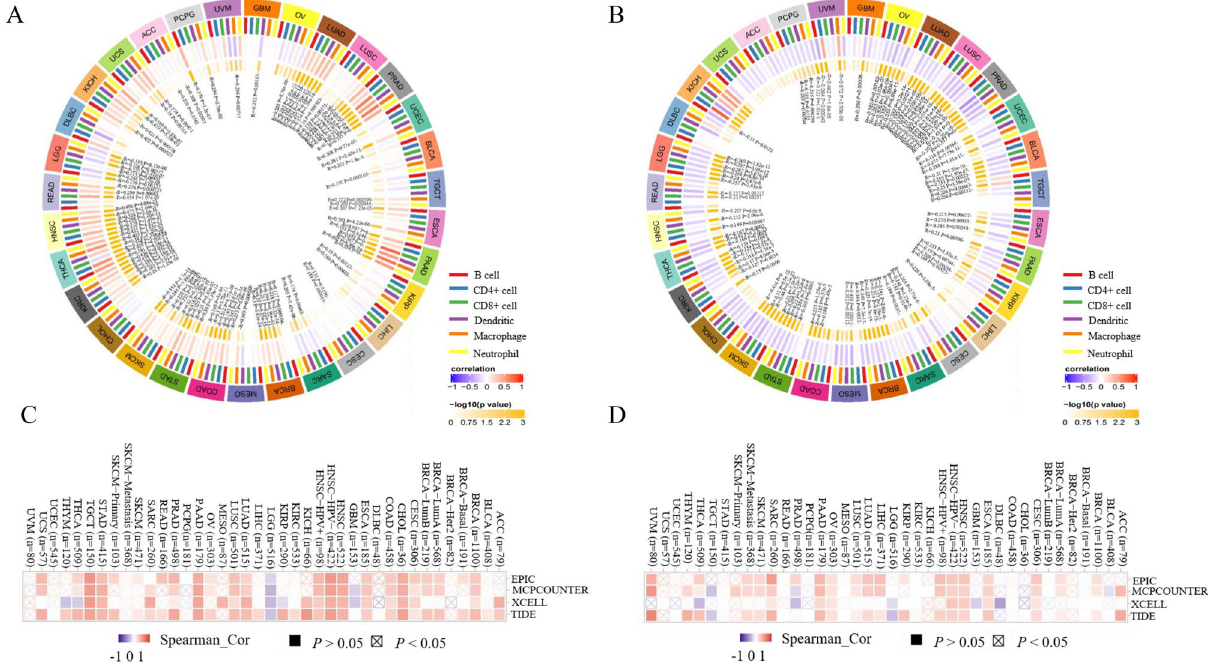
Figure 6. The correlation between genes expression and immune infiltration levels in pan-cancer. The correlation between immune cells including B cells, CD4 + T cells, CD8 + T cells, neutrophils, macrophages, dendritic cells and PIK3R1 expression ( A ), PIK3R2 expression ( B ). Analysis through the SangerBox 3.0 tools (http:// sange rbox. com/ Index). The correlation between the immune infiltration level of cancer-associated fibroblast and the expression level of PIK3R1 ( C ), PIK3R2 ( D ). Analysis through the TIMER 2.0 (http:// timer. cistr ome. org/ datab ase). EPIC, MCPCOUNTER, XCELL, TIDE algorithms were utilized to analyze the correlation between genes expression and immune infiltration level of cancer-associated fibroblast. P < 0.05 was considered as statistically